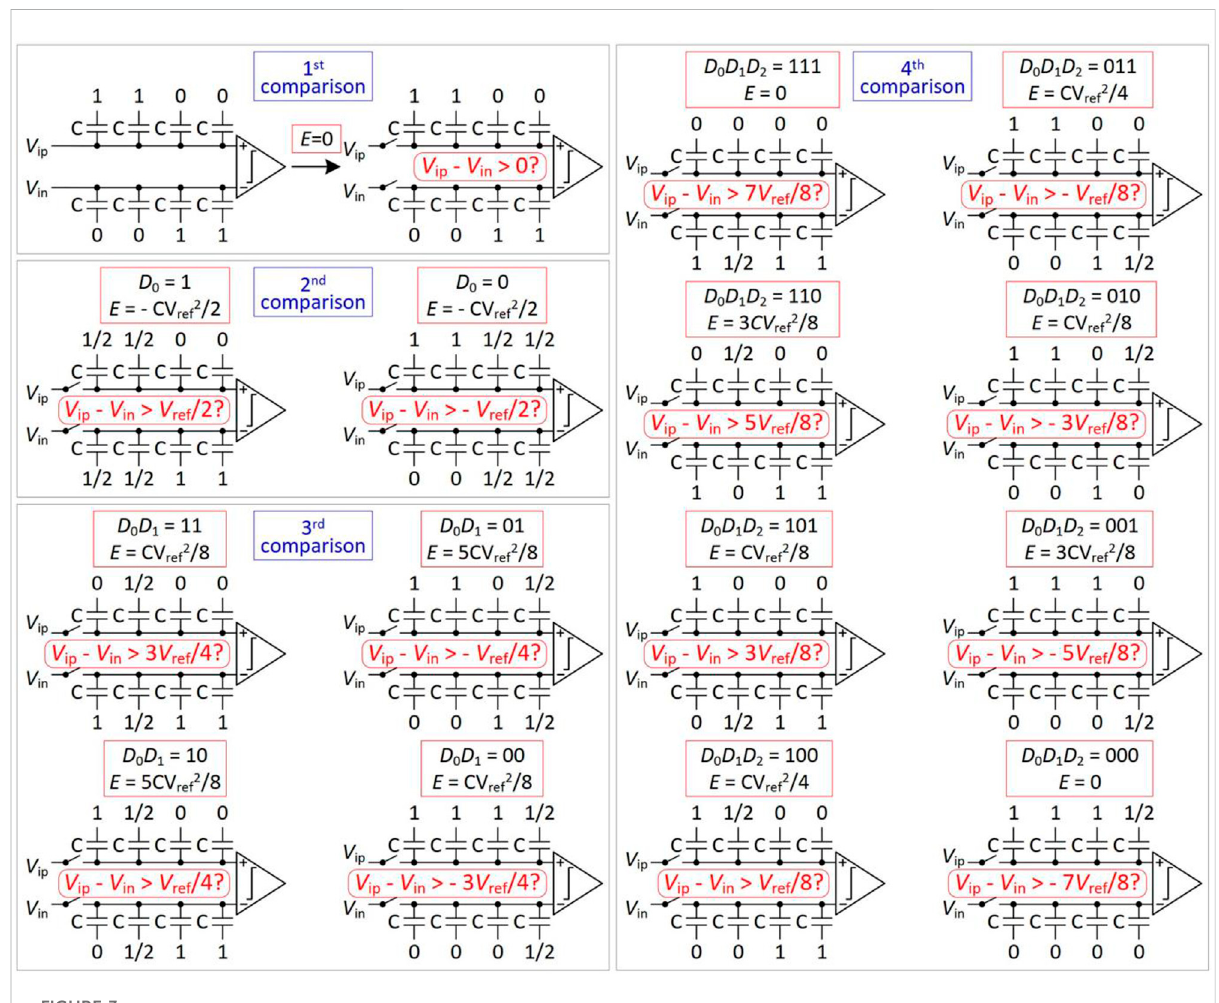
FIGURE 3 Switching procedure of 4-bit SAR